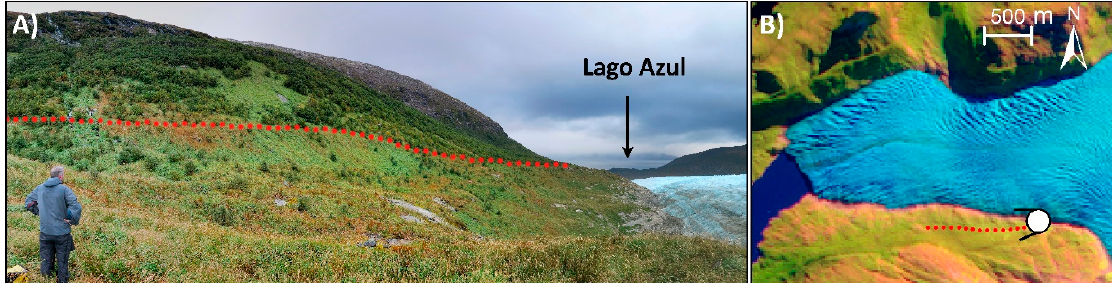
Figure 3. ( A ) View onto the southern lateral moraine of Schiaparelli Glacier: red dotted line indicates the abrupt vegetation transition into a more dispersed tree stand. The sampling area was situated between the recent glacial tongue and the red lines. ( B ) Position and perspective of the photograph ( A ) indicated by white circle (background: false color composite Sentinel-2, acquisition date 04-07-2017).